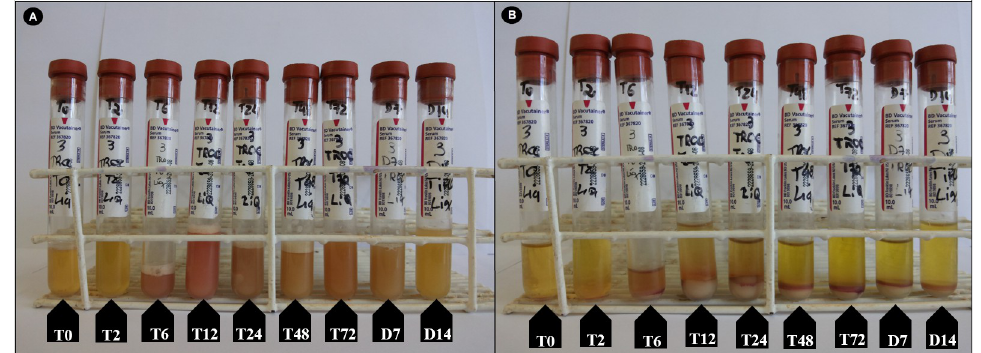
Table 1. Mean and standard deviation (SD) of total nucleated cells count in the peritoneal fluid of healthy horses (CG) and horses submitted to cecal trocarization with a cecal needle (G1) or a cattle trocar (G2).